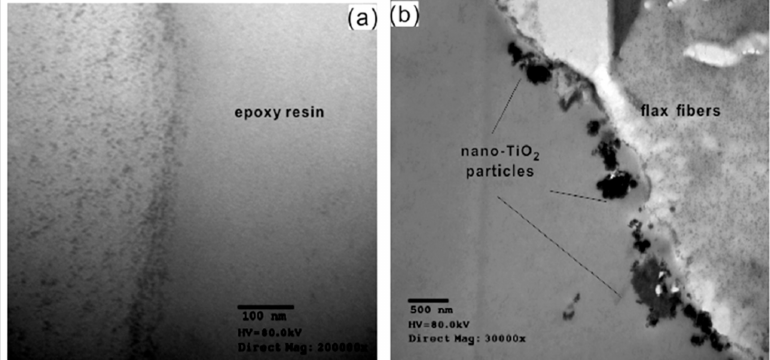
Figure 12. Transmission Electron Microscope (TEM) images of flax fibre cross sections: ( a ) control flax fibre, ( b ) a nano-TiO 2 grafted flax fibre (reprinted with the permission from Wang et al., 2015